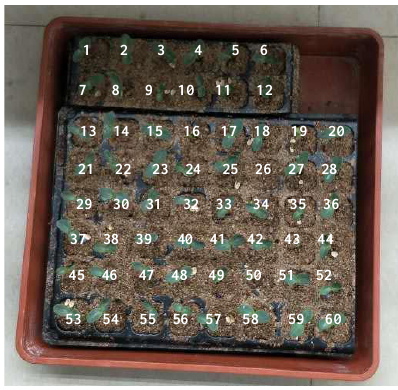
Figure 12. Label of each seedling cell in plug tray.